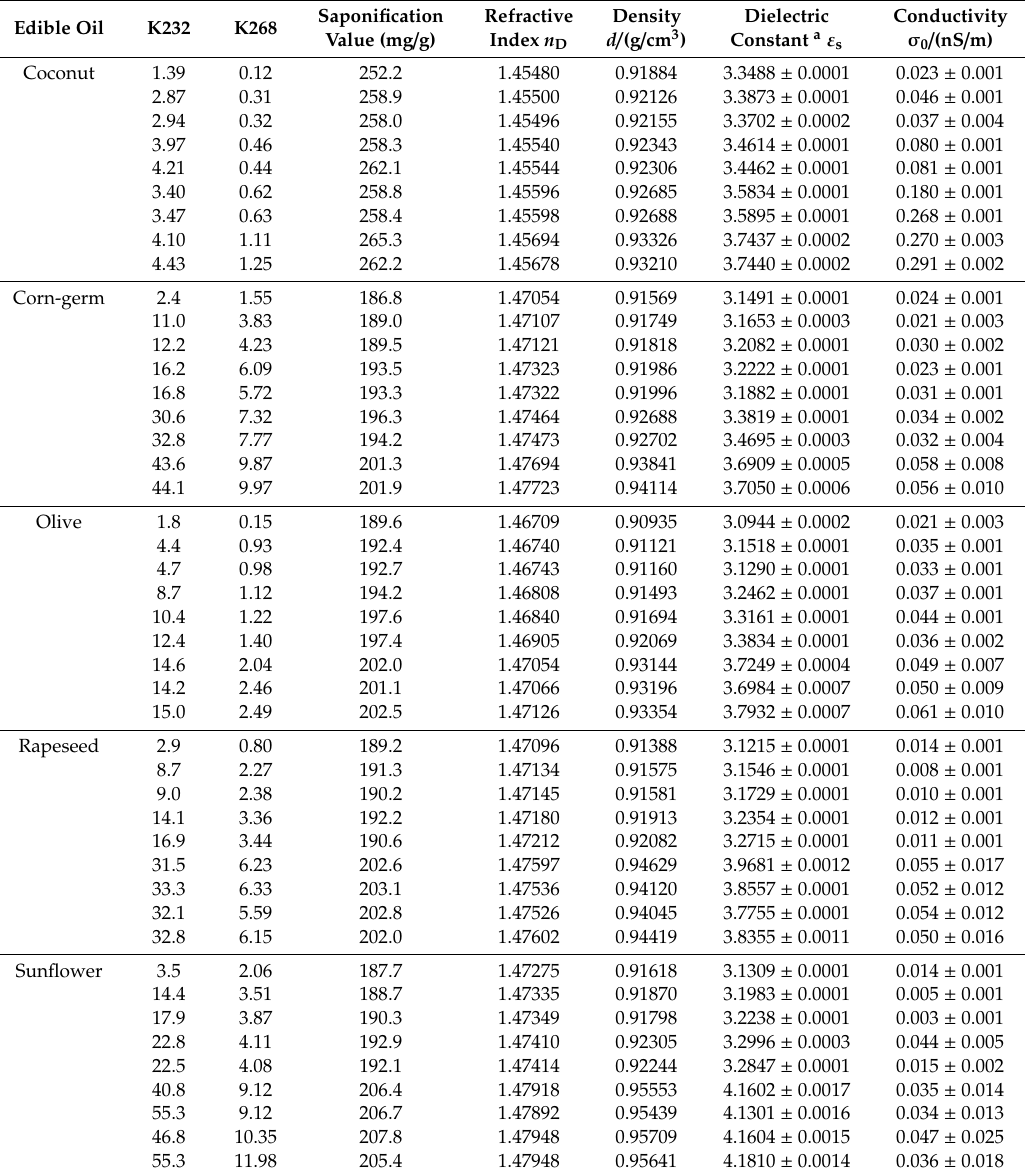
Table 1. Parameters measured for the edible oils before and during the thermal treatment, determined at 25 ◦